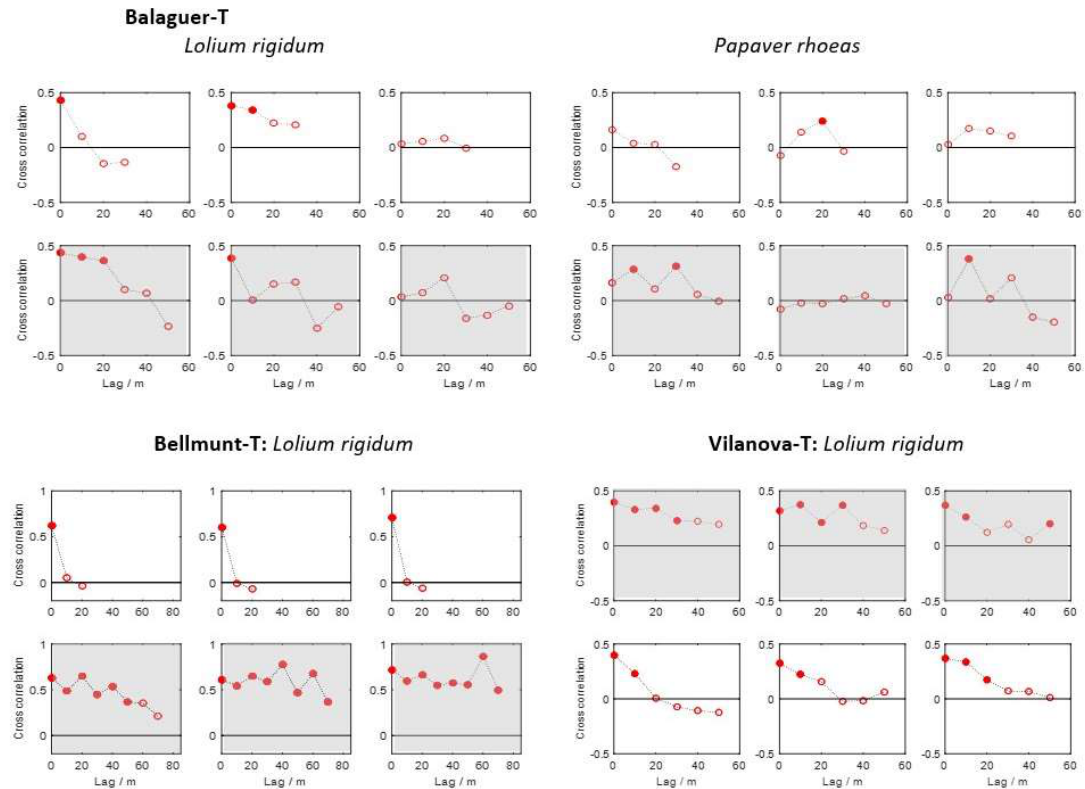
Figure 7. Cross-correlation of weed cover between years of the main weeds in the harrow-tilled fields (T). First row graphs: N–S direction, second row: E–W direction. Rows with grey background: direction of traffic. First column graphs: cross-correlation years 1 and 2, second column years 1 and 3 and third column years 2 and 3. Solid symbols mean that cross-correlation is significantly different from random.